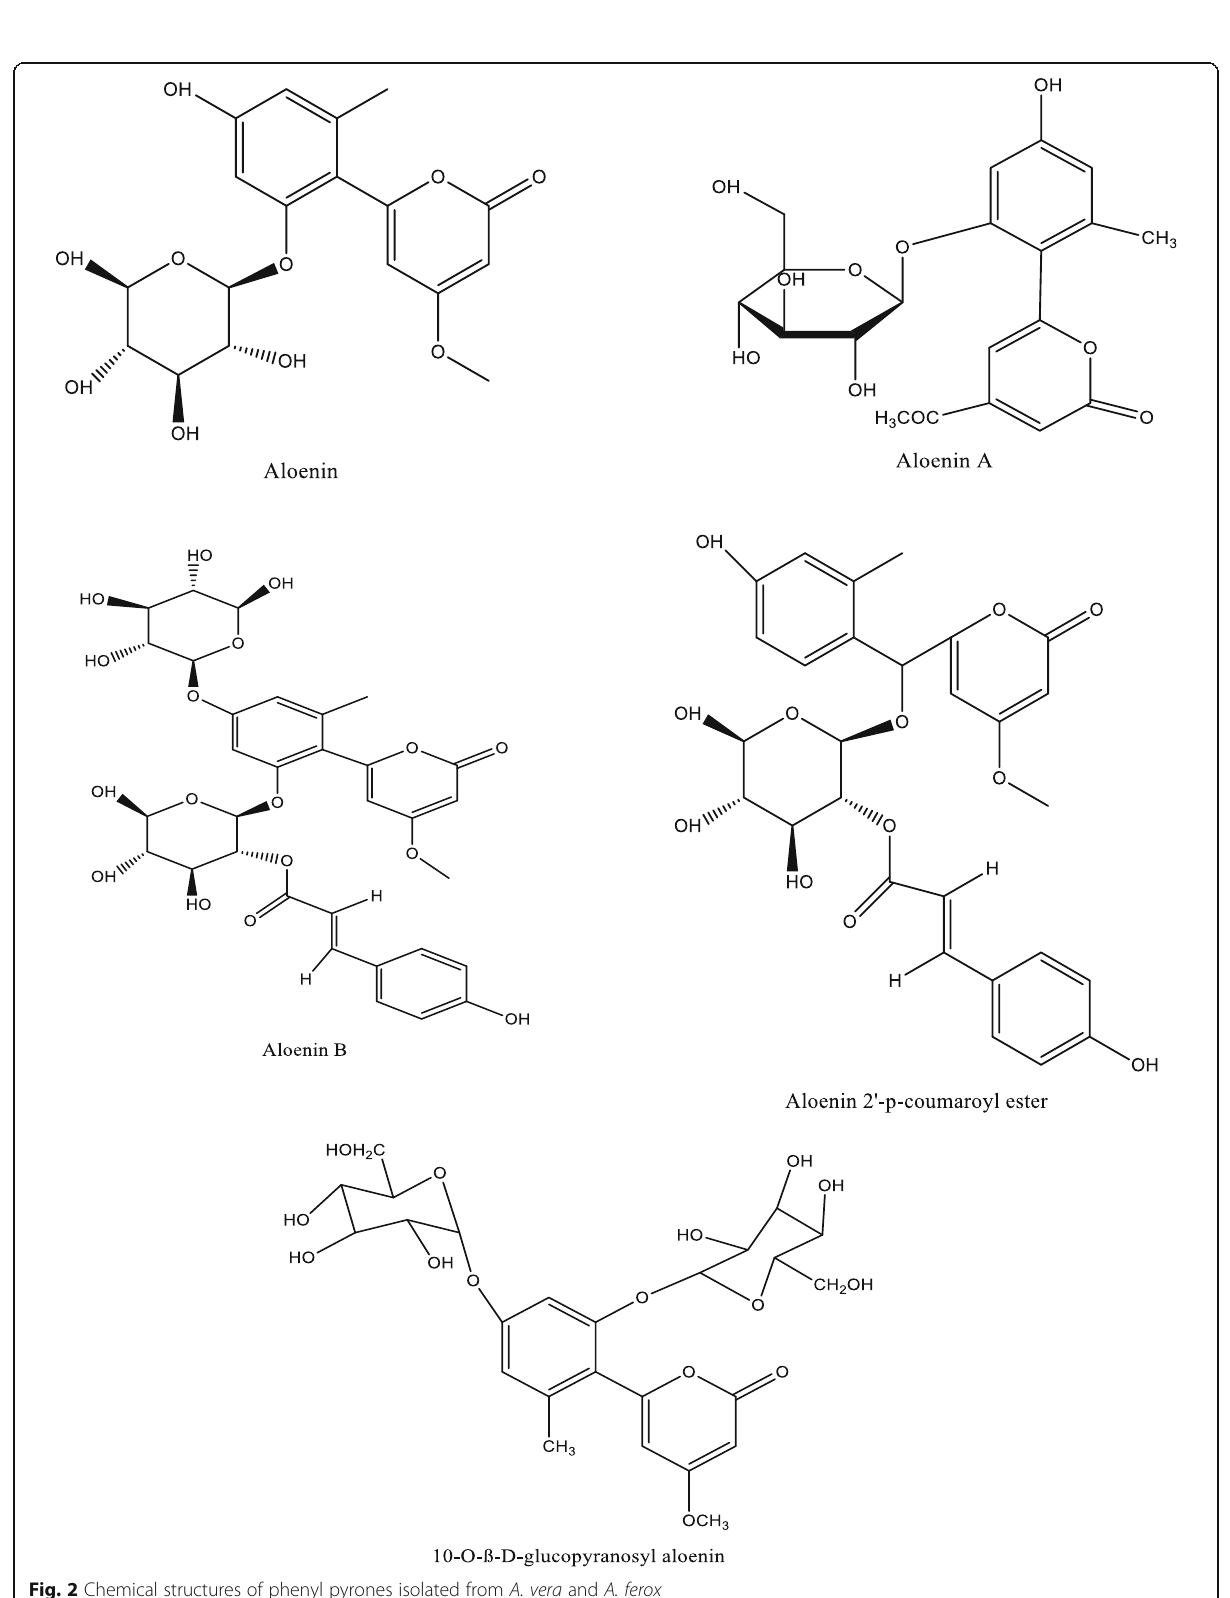
Fig. 2 Chemical structures of phenyl pyrones isolated from A. vera and A.